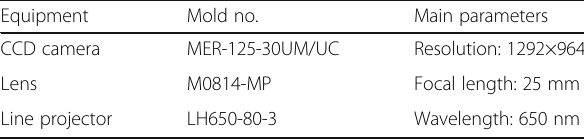
Table 2 Experimental equipment